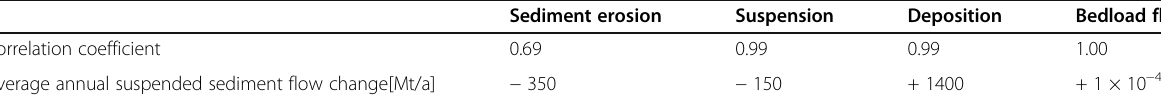
Table 4 Statistics of simulations excluding sediment dynamics processes at Obidos Sediment erosion Suspension